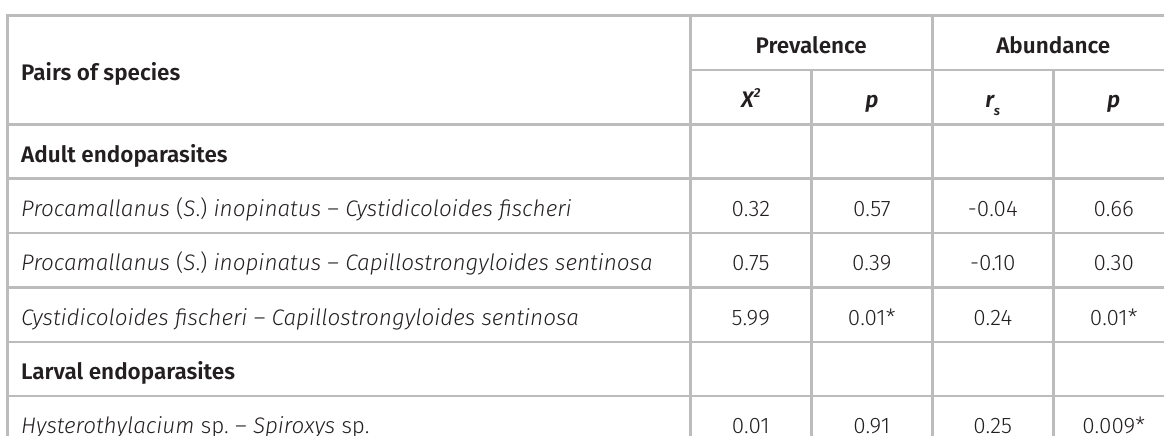
Table IV. Analysis of the parasitic descriptors of co-occurring species in Pygocentrus piraya from Três Marias reservoir, upper São Francisco river, state of Minas Gerais, Brazil.